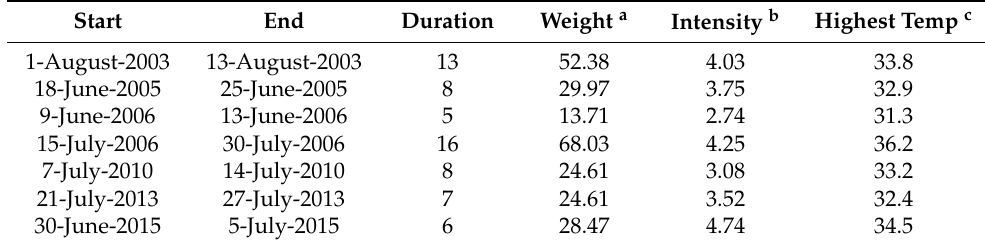
Table 2. Summary of heatwaves in Belgium from 2000–2015